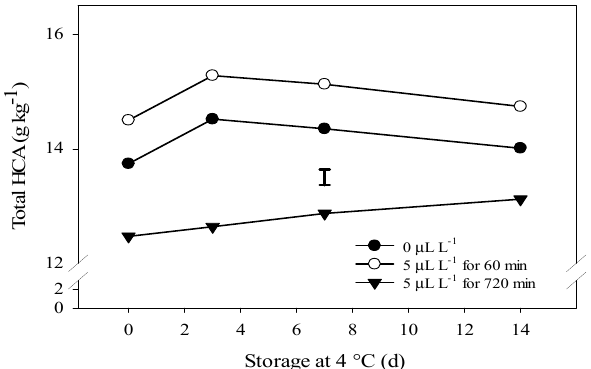
Figure 5. Broccoli florets were treated with three different doses of O 3 : ( ● ), 0 µL L − 1 ; ( ○ ), 5 µL L − 1 for 60 min (hormetic dose); and ( ▼ ), 5 µL L − 1 for 720 min (high dose). The content of total HCA was followed during 14 days. The vertical bar represents the LSD value (0.05) = 0.54. d, day. In addition to the secondary metabolites analysis, the gene expression of key enzymes of the GLS and phenylpropanoid pathways were evaluated. The most affected gene expression corresponded to the GLS pathway. The high dose of O 3 at 5 µL L − 1 of O 3 for 720 min amplified the expression of CYP79B3 by almost 4-fold, and the expression of CYP79F1 was increased by 2.5-fold (Figure 6). Furthermore, the hormetic dose of 5 µL L − 1 of O 3 applied for 60 min significantly ( p < 0.05) increased the expression of phenylalanine N-hydroxylase (CYP79A2) by 4-fold compared to the control samples. Less significant results were observed with the phenolic pathway, where only the hormetic dose of ozone doubled the expression of chalcone synthase compared to the non-exposed florets (Figure 6). The levels of overexpression of GLS were in hand with the overall enhancement of total glucobrassicins and aliphatic GLS due to the hormetic dose of ozone (Figure 3). The same applied to HCA, where overall enhancements corresponded to the florets treated with the hormetic dose (Figure 5). Moreover, the overexpression of gene expression was also related to the average induction of each compound class, being superior on GLS (Figure 4).